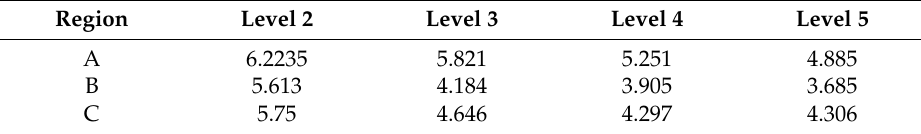
Table 5. Sub-aperture spot size for each level in regions A, B, and C. Unit: mm.